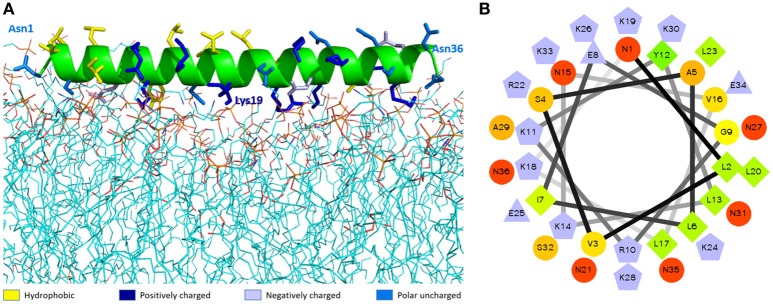
The molecular modeling of DLP-PH structures. (A) Theoretical docking study of DLP-PH with E. coli model membrane. The secondary structure of DLP-PH is showing in green cartoon, the main chain is hided and side chains are representing in sticks with different colors (designated in the figure according to the properties of the residues). The phospholipids are presenting in lines with carbon atoms in cyan, oxygen atoms in red, nitrogen atoms in blue, and phosphorus atoms in orange. (B) Helical wheel projection of DLP-PH with the N-terminal domain in the inner circle and the C-terminal domain in the outer circle.